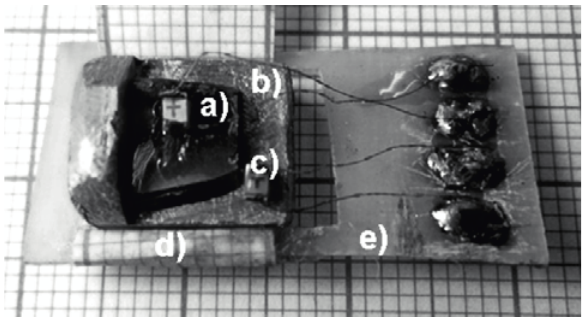
Figure 7. The appearance of the experimental setup for direct ∆Q-measurements of MCE materials: a) the sample, b) the copper block, c) the diode for temperature measuring, d) the paper, e) the textolite framework.